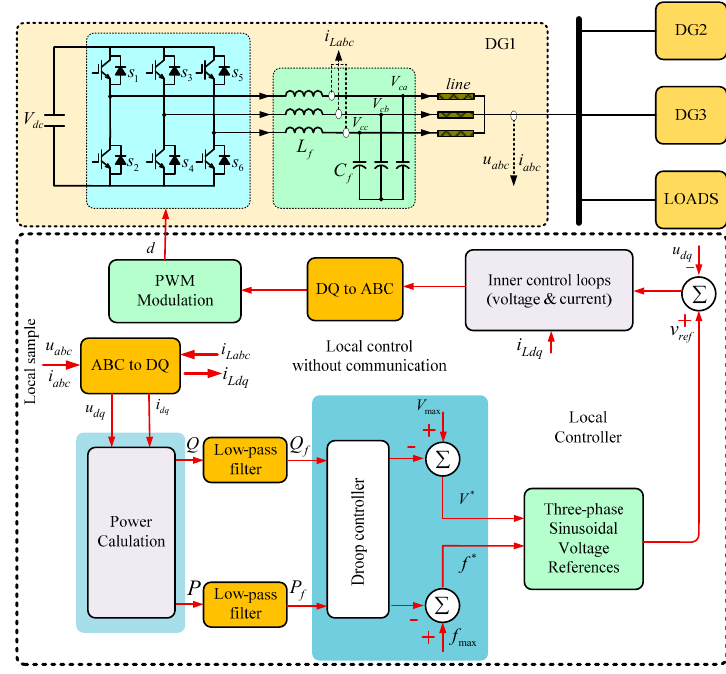
Figure 8. Scaled-down simulation AC MGs. Table 2. Parameters for simulation.